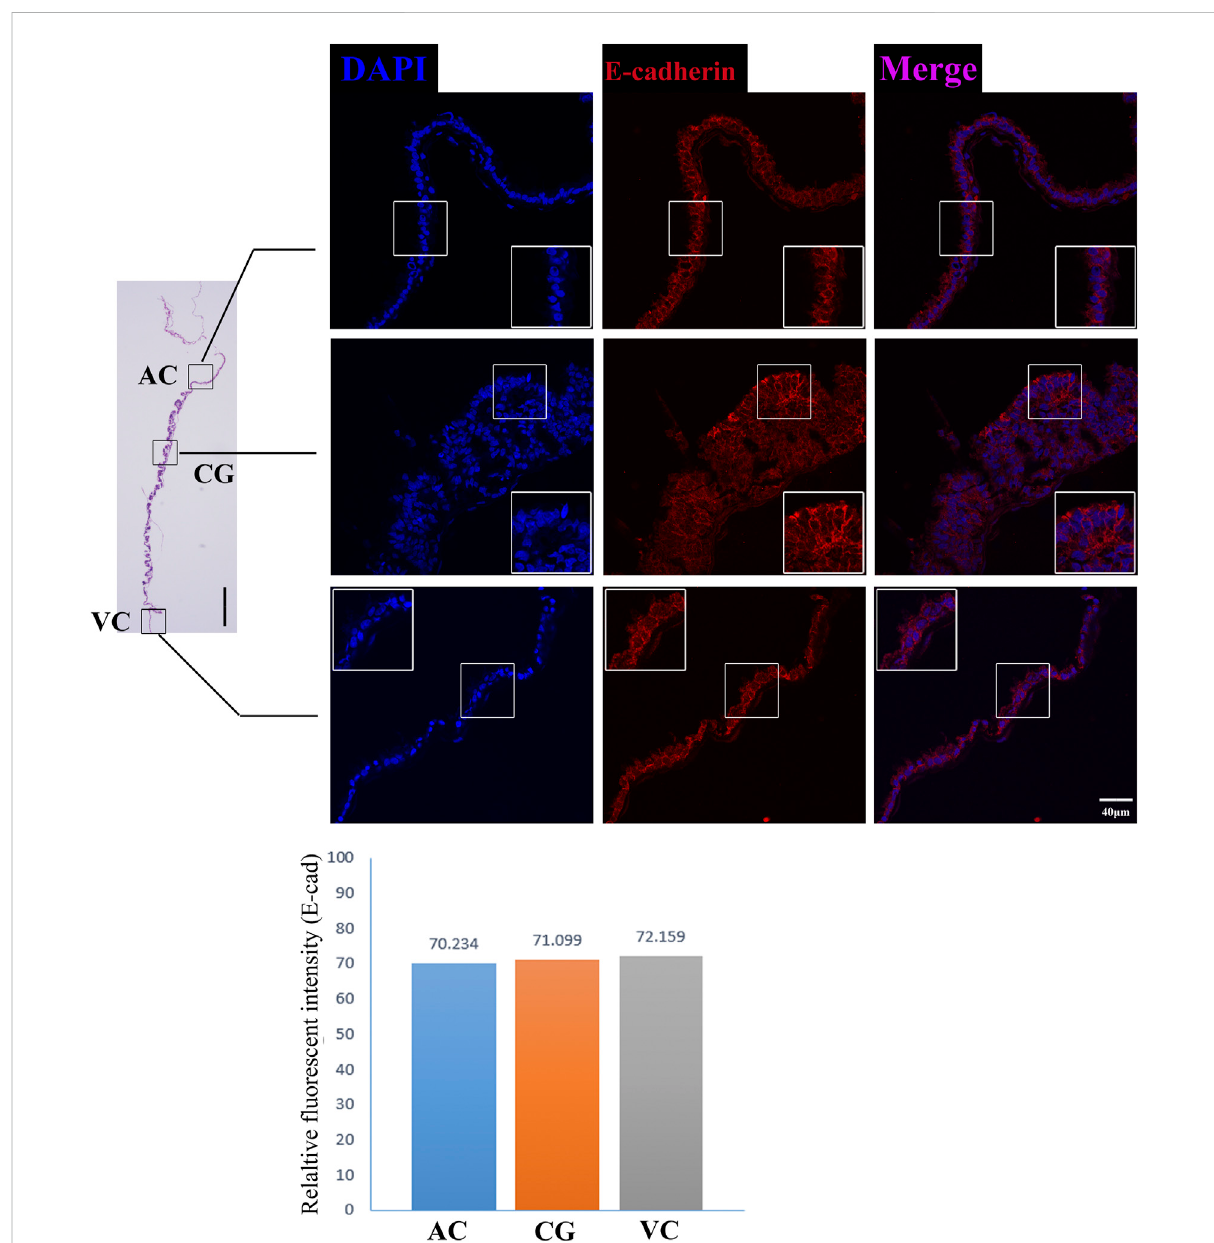
E-cadherin immuno fl uorescence on day 30 equine chorion., Histological images including allantochorion (AC), chorionic girdle (CG), and vitelline-chorion(VC)areusedtoclarifythelocationoftheimmuno fl uorescenceview.Below,thehistogramshowsthe fl uorescenceintensityforred fl uorescence of E-cadherin. An enlarged view of the area is shown in the white frame. Left bar = 400 μ m, right bar = 40 μ m.